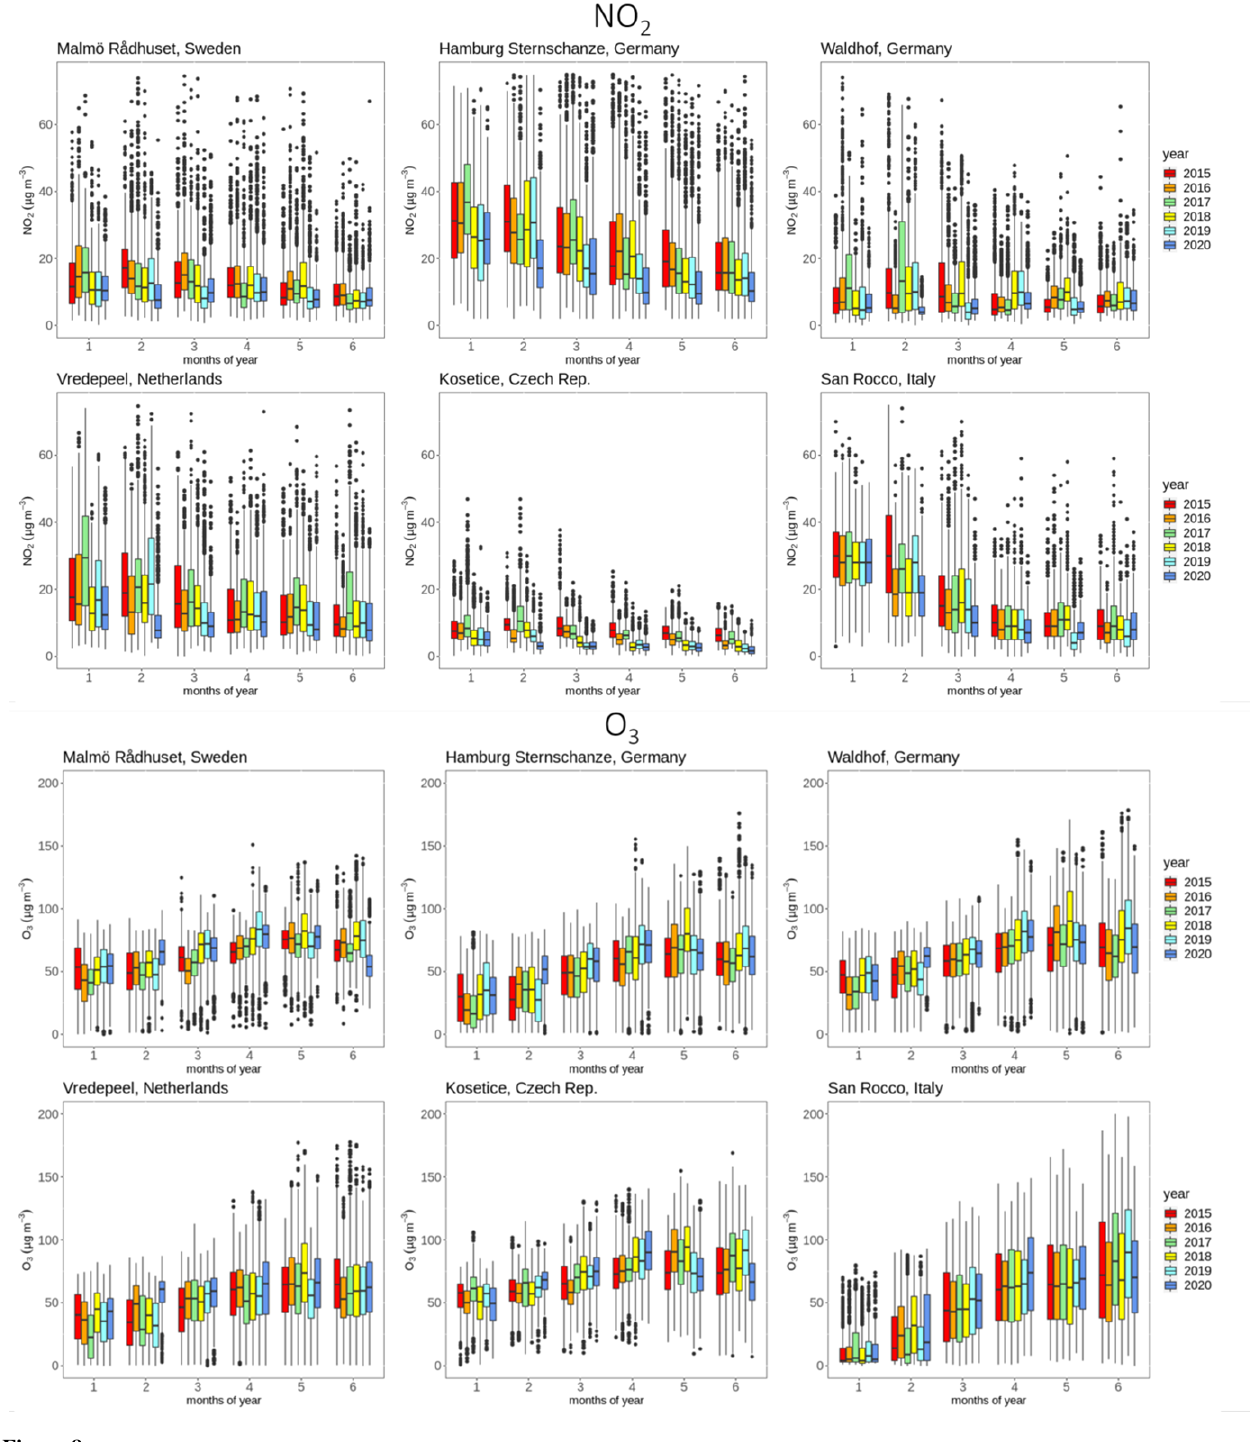
https://doi.org/10.5194/acp-21-13931-2021 Atmos. Chem. Phys., 21, 13931–13971,